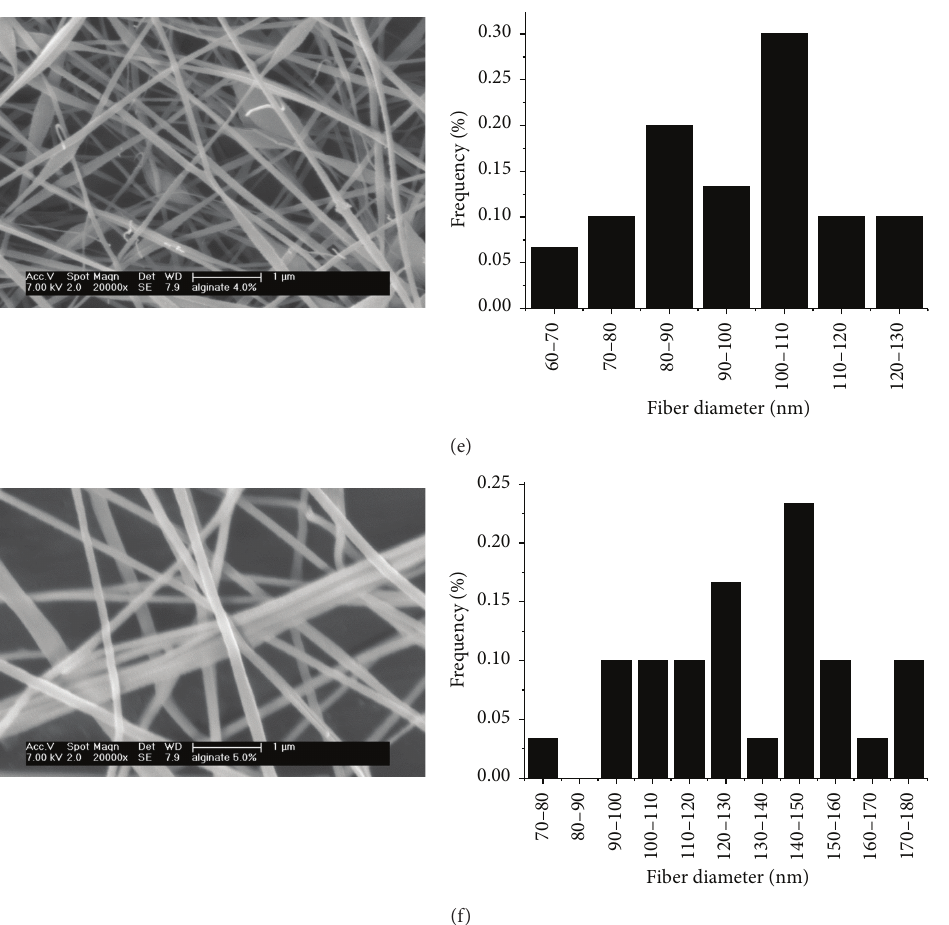
Figure 2: Effect of solution concentration on fiber morphology and diameter distribution with 1: 1 NaAlg/PEO ratio (magnification = 20,000x). Solution concentration: (a) 1%; (b) 1.5%; (c) 2%; (d) 3%; (e) 4%; (f)